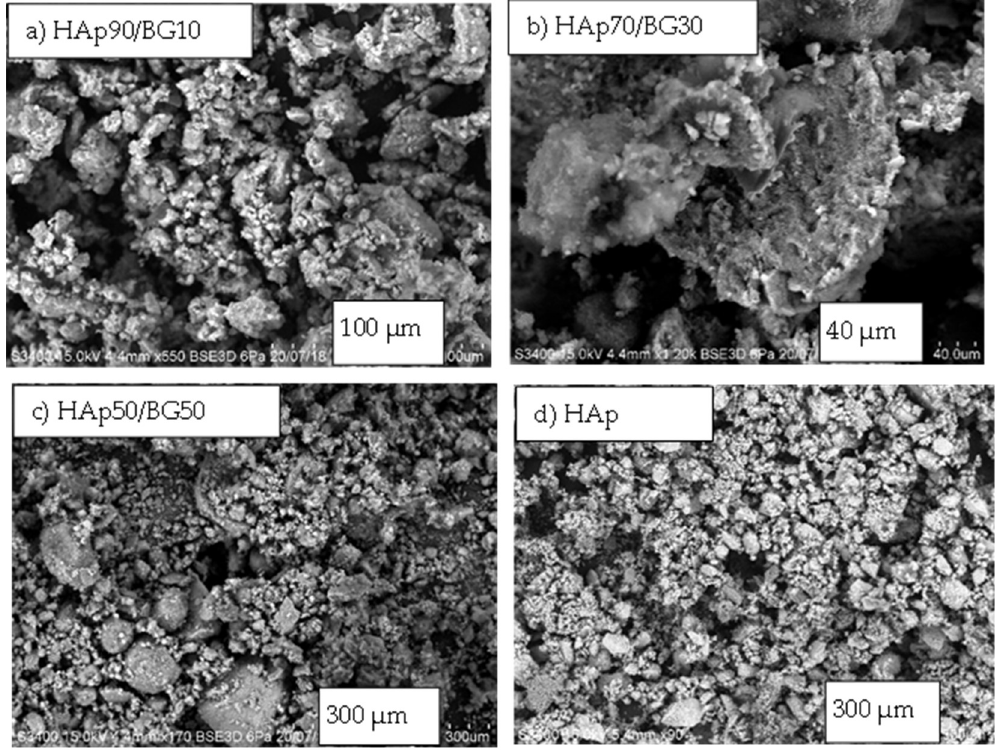
Figure 12. SEM images of HAp and HAp/BG composite nanopowder after immersion in SBF. To confirm the formation of an apatite layer on the surface of HAp and HAp/BG nanopowders after immersion in SBF solution for 14 days, we used the FTIR results (Figure 13). From the FTIR spectra (Figure 13), after immersion of samples in SBF solution, different P-O bonds in 600–700 and 900–1100 cm − 1 wavenumber are sharper than when the sample is not located in SBF solution, as is shown in Figure 13. This indicated that the increased percentage of apatite phase was due to the formation of an apatite layer after immersion of samples in SBF solution. As described before, during sintering